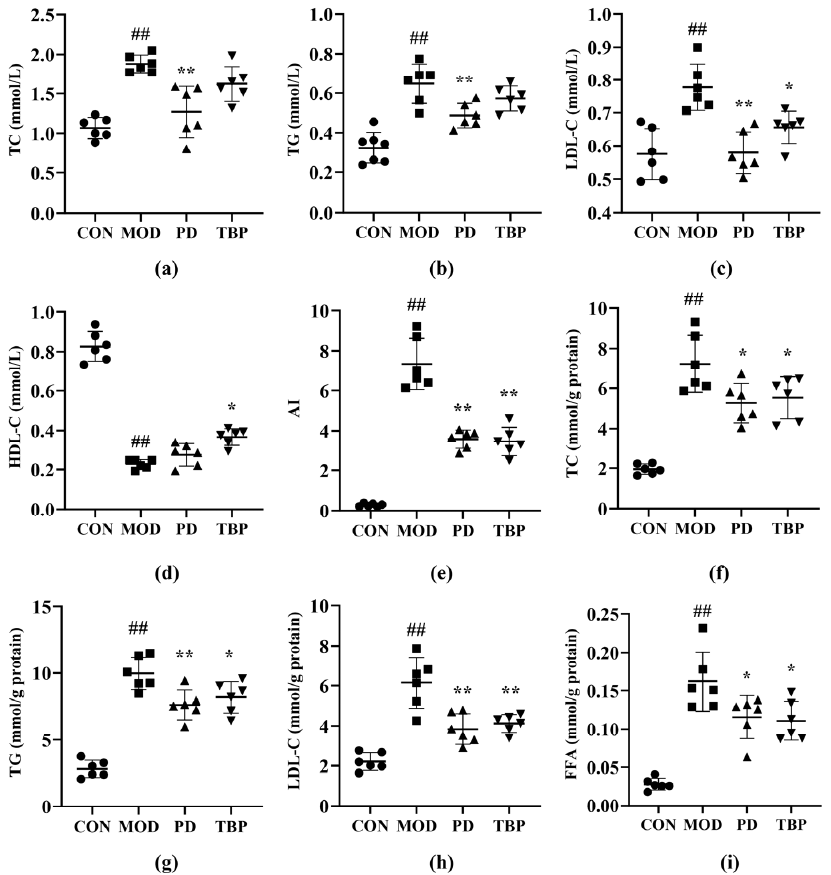
Figure 4. Effect of TBP on serum TC ( a ), serum TG ( b ), serum LDL-C ( c ), serum HDL-C ( d ), AI ( e ), liver TC ( f ), liver TG ( g ), liver LDL-C ( h ), and liver FFA ( i ) in rats consuming a HFD. Values are expressed as the mean ± SD ( n = 6) for all groups. ## p < 0.01 denotes statistically significant differences between the CON and MOD groups. ** p < 0.01 and * p < 0.05 denote statistically significant differences with MOD group.